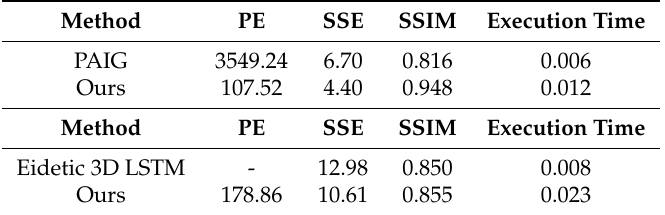
Table 3. (top) Position error (PE), sum of squared error (SSE), and similarity index (SSIM) obtained by the PAIG model and our model for FDB1. (bottom) SSE and SSIM obtained by the Eidetic 3D LSTM model and our model for FDB2. Execution time represents the average time (seconds) to predict one